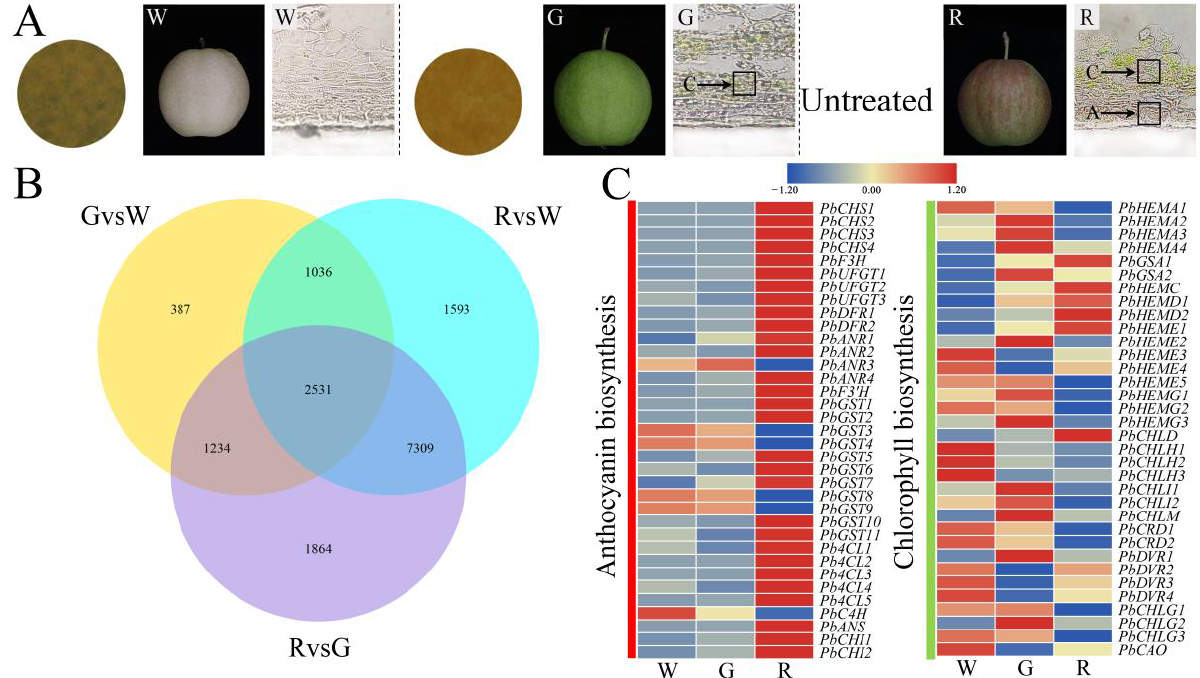
Data are the mean ± standard error ( n = 5). Different lowercase letters within a column are statistically significant at p < 0.05 (Duncan’s test). L*, a*, and b* represent different fruit color parameters. BB-B: brown–black bag, YW-B: yellow–white bag, W-B: white bag, CK: no bag.